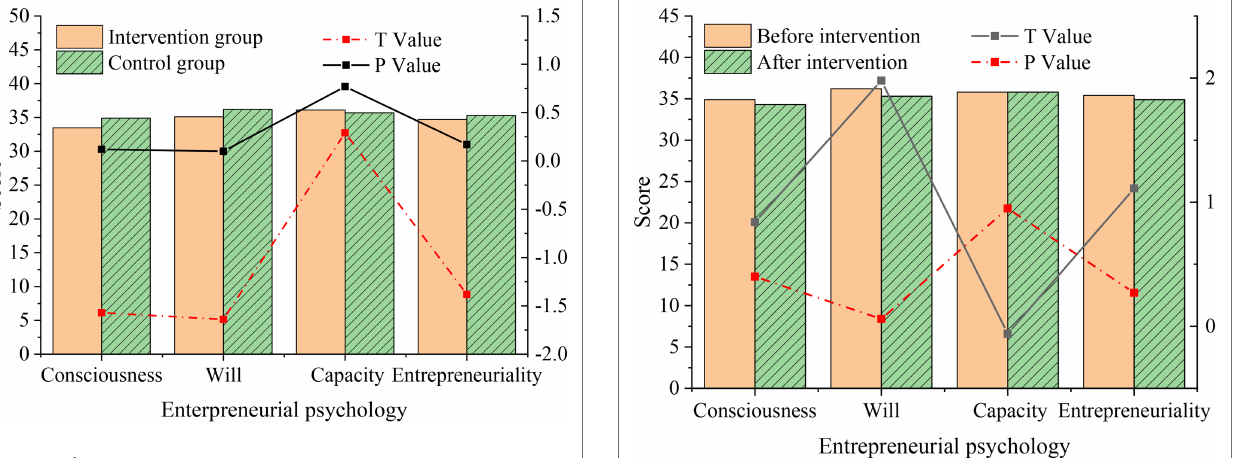
FIGURE 7 | Pre-test difference of entrepreneurial psychology between intervention group and control group.